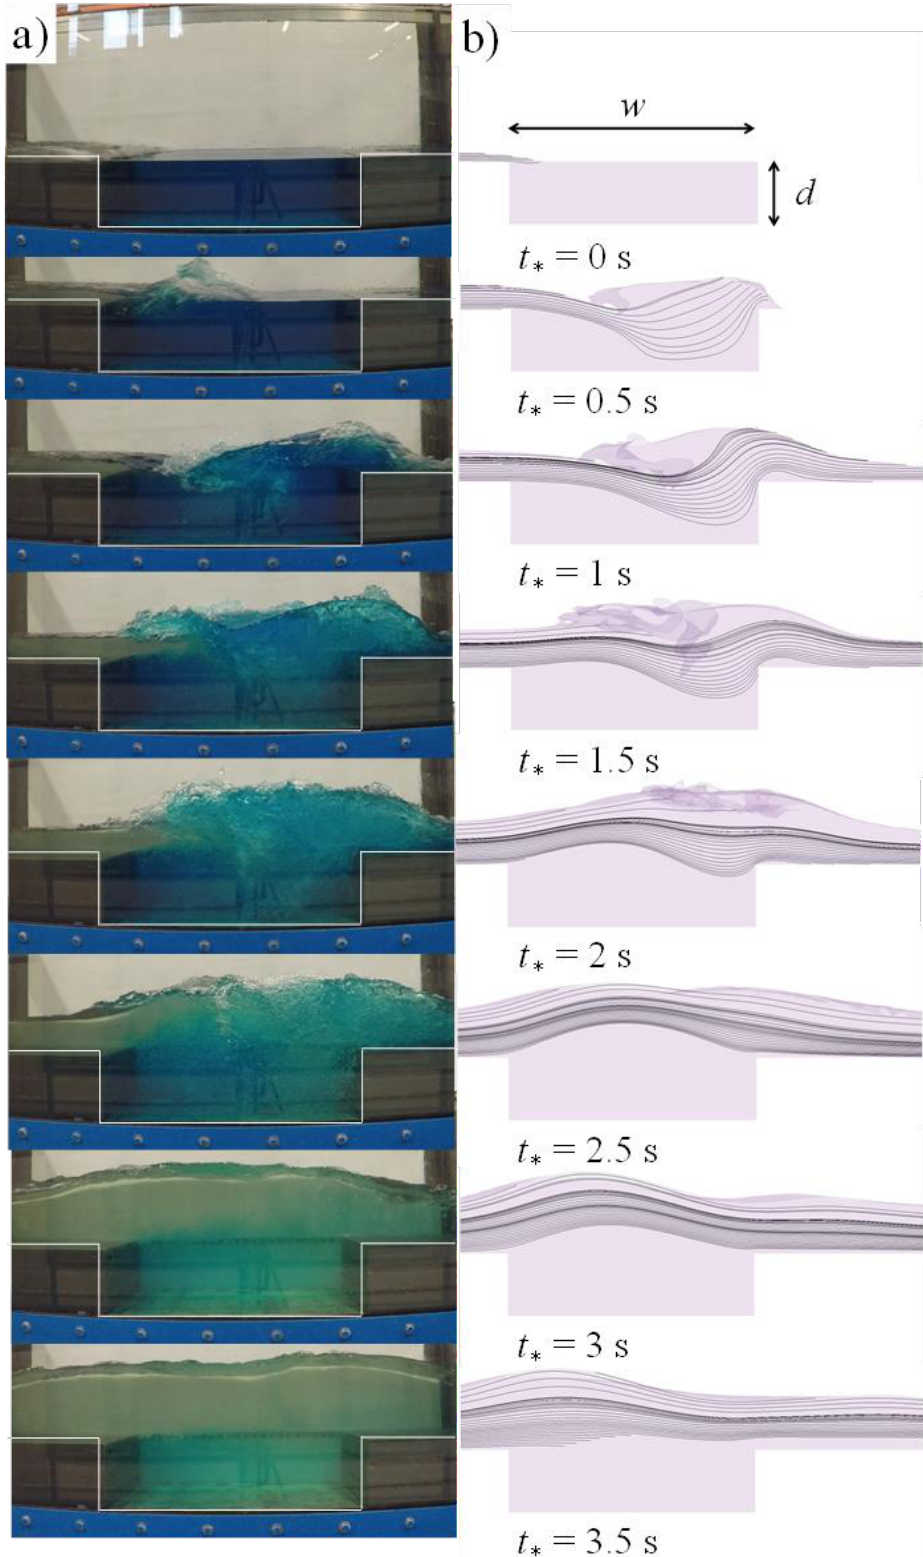
Figure 9. Time history of water surface profiles of a bore from an impoundment with a depth of d o = 0.3 m, passing over a canal with a width of w = 0.6 m and a depth of d = 0.15 m: ( a ) side-view images; ( b ) simulated water surface profile and streamlines.